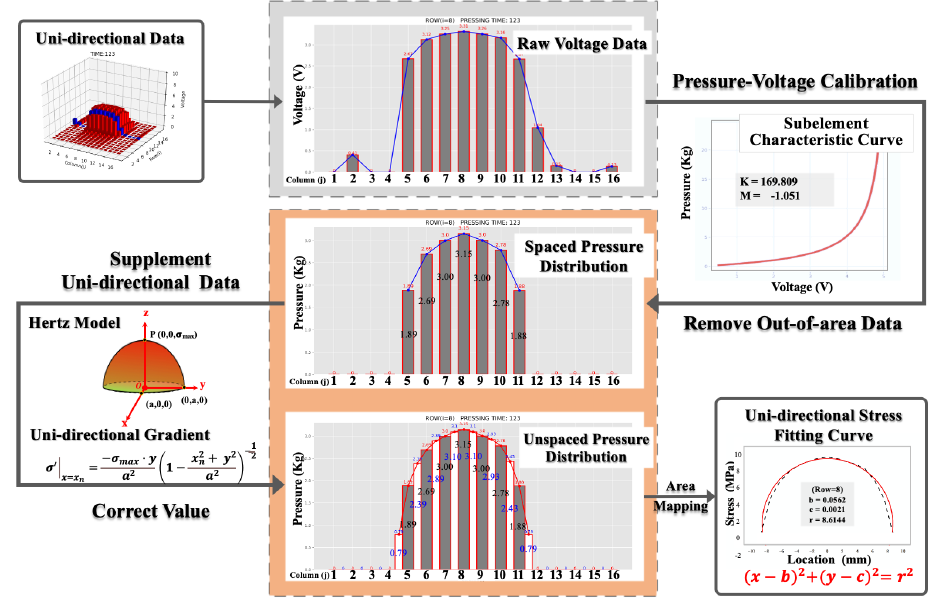
Figure 6. Procedures of uni-directional data